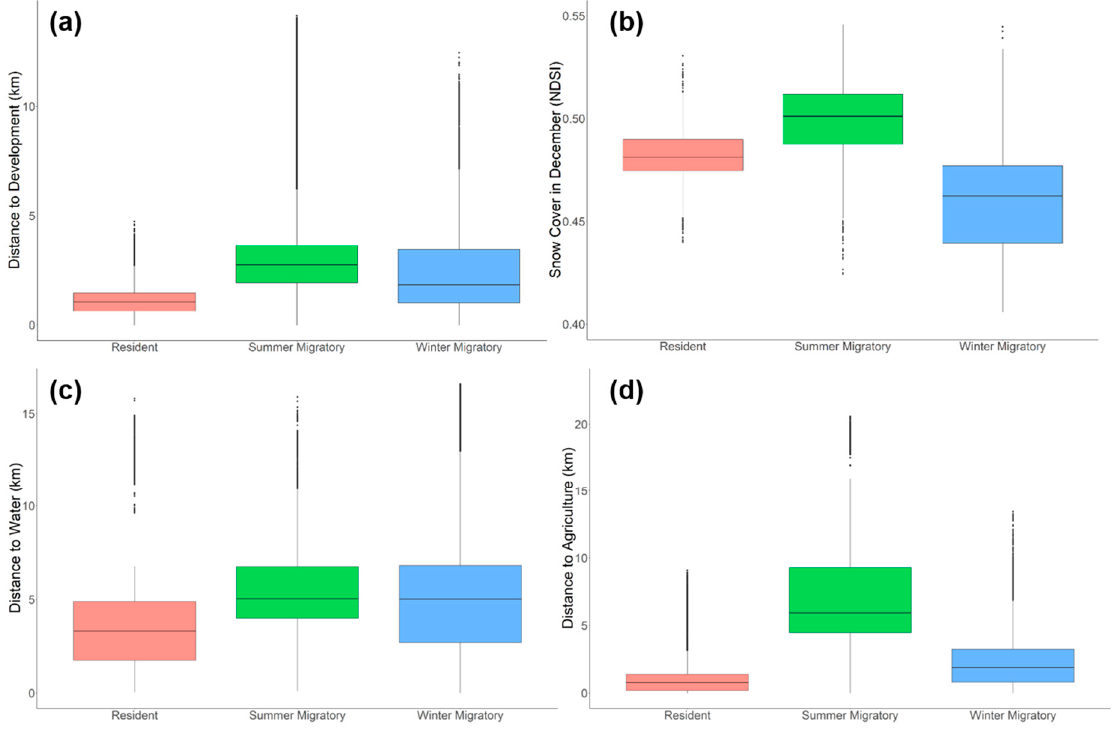
Figure 4. Environmental covariates of the four most important variables in the random forest, where the red boxplots designate the resident niche, green designates the summer migratory niche, and blue designates the winter migratory niche. ( a ) Distance to development, ( b ) snow cover (NDSI) in December, ( c ) distance to water, and ( d ) distance to agriculture.